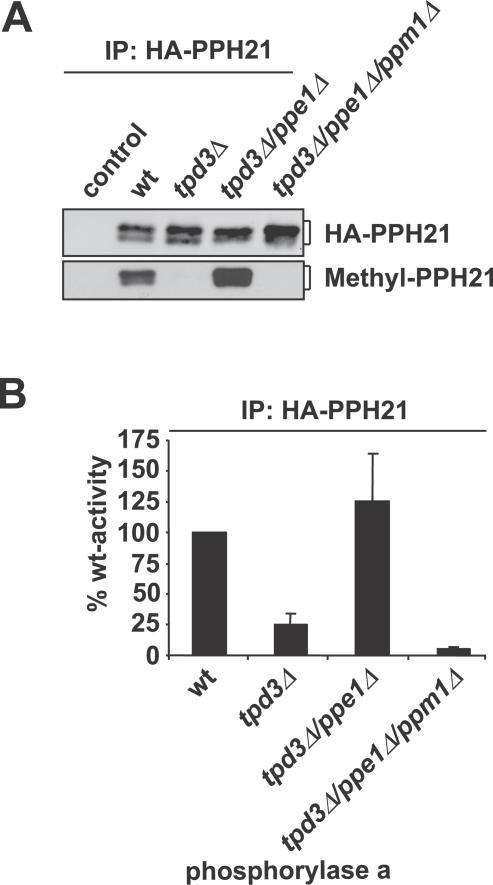
C Subunit Methylation Is Required for the Restoration of C Subunit Activity in the tpd3Δppe1Δ StrainHA-tagged PPH21 was immunoprecipitated from lysates of wild-type (wt), tpd3Δ, tpd3Δ/ppe1Δ, and tpd3Δ/ppe1Δ/ppm1Δ cells. The immunoprecipitates (IP) were (A) analyzed by 10% SDS-PAGE/immunoblotting and (B) assayed for phosphatase activity using phosphorylase a as substrate (n = 7).